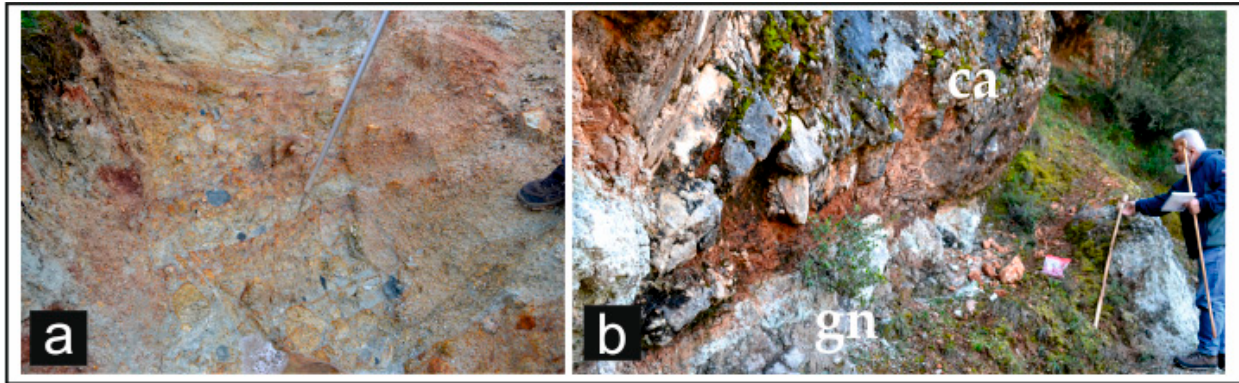
Figure 11. Key outcrops of two most prominent N-S trending faults in the epicentral area. ( a ) Cataclastic zone of MeF south of homonymous village. Photo is taken looking SE, and width of photo is approximately 1.5 m. ( b ) Cataclastic zone developed in DF including 1.5 m thick reddish to white rocks in central part of photo. Reddish rocks represent cataclasis in calcareous rocks, and whitish rocks represent gneissic cataclasites. Carbonate rocks are exposed in the DF hanging-wall block (ca) and gneisses (gn) in its footwall block. Photo is taken looking south.